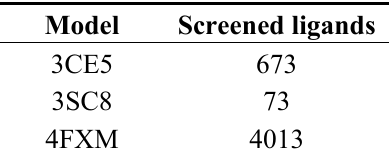
Table 4. Number of ligands screened by the natural database by means of the single pharmacophore models generated starting from the experimental structures 3CE5, 3SC8 and